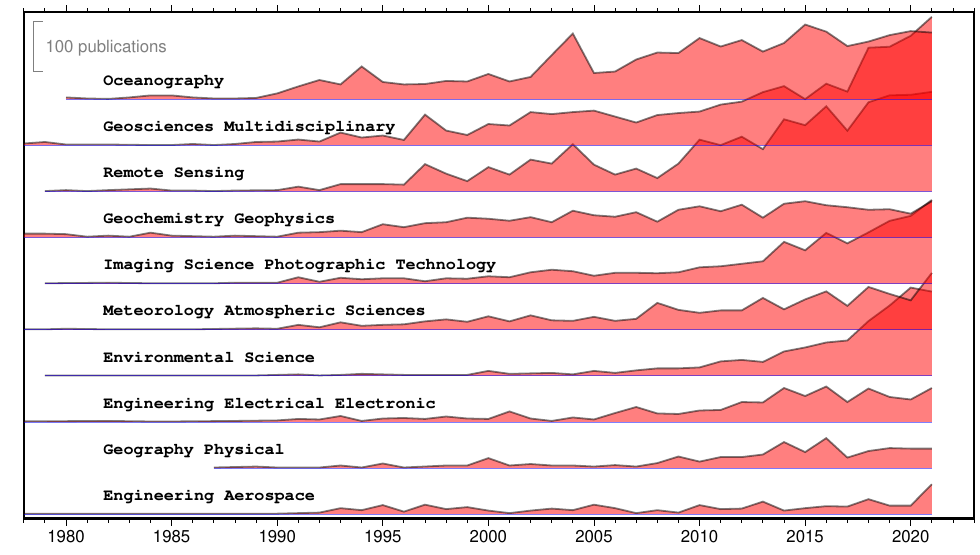
Figure 11. The number of annual publication related to the top 10